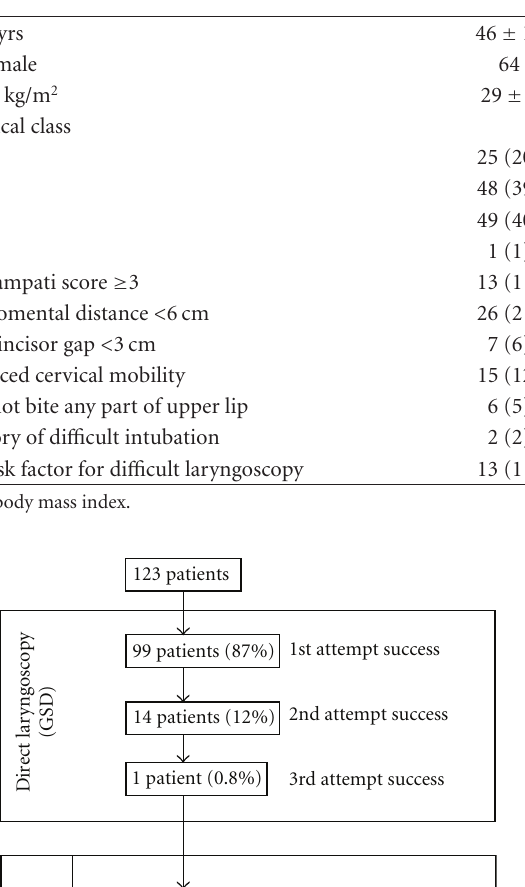
Table 1: Patient characteristics. Data as %, n (%), or mean ± SD.